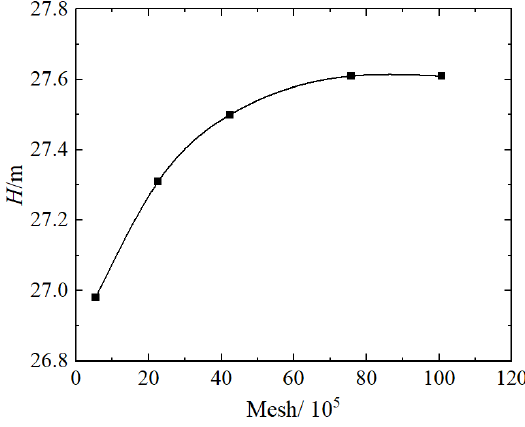
Figure 3. Mesh independence study.